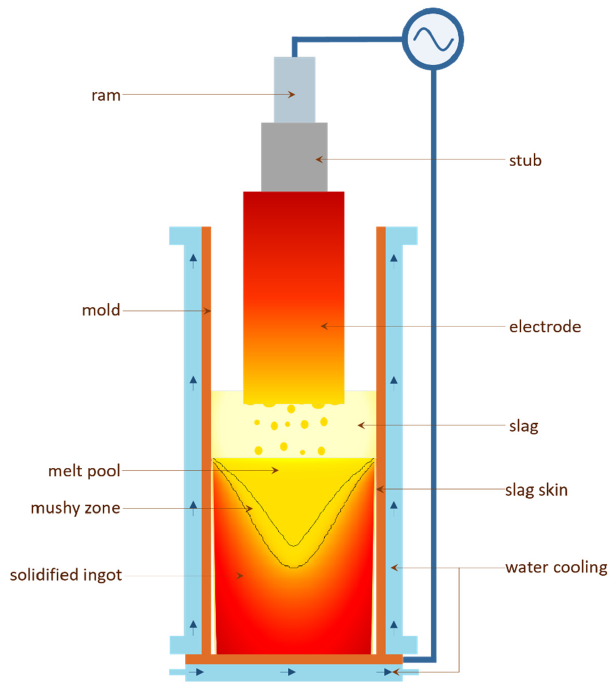
Figure 1. Schematic representation of the electroslag remelting process.